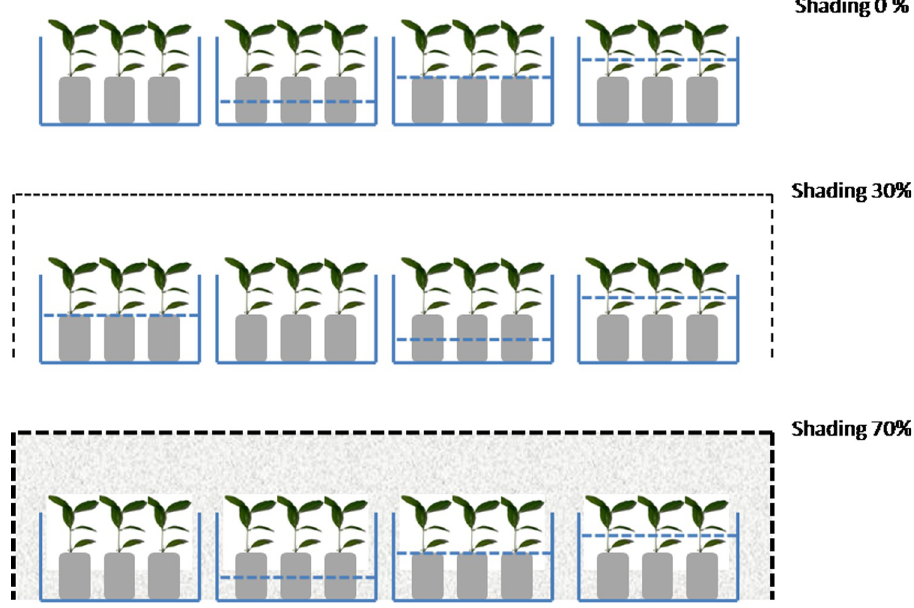
Fig 1. Layout of shading and inundation experiment in the nursery. Blue dashes indicate the ground water (GW) level, at GW level 10 cm (half of polybag’s height); GW level zero (the height of the polybag), and ⅓ stem height flooding. The diagram with no blue dashes indicates the control treatment (fully